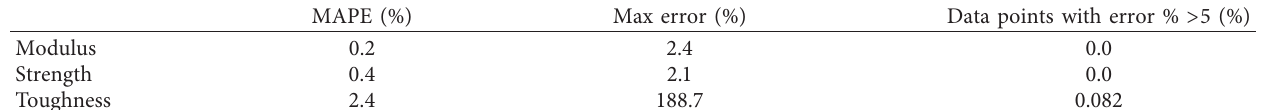
Table 3: CNN model performance for 16 × 16 grid.